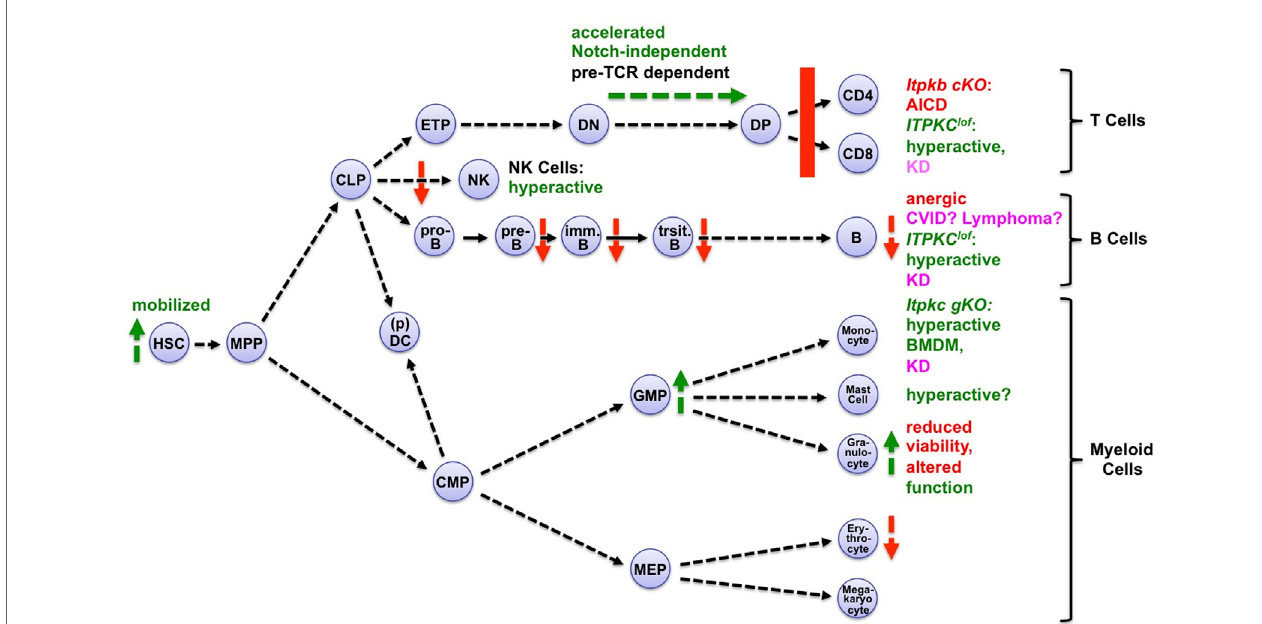
FigURe 3 | Itpks control multiple aspects of hematopoiesis. Shown are aspects of hematopoiesis affected positively (green symbols and fonts) or negatively (red symbols and fonts) by inactivation of Itpkb or Itpkc. Pink, human diseases associated with loss-of-function (lof) alleles of ITPKC (Kawasaki disease, KD) or ITPKB (common variable immunodeficiency, CVID). Abbreviations: cKO , conditional, gKO , germline knockout mice; AICD, activation-induced cell death; BMDM, bone marrow-derived macrophages. Hematopoietic cell stages and pathways are explained in the legend to Figure 2 . For more details and references, see text. Mast cells express Itpkb and produce IP 4 after stimulation (53). Small-molecule Itpk inhibition might augment their activation (54, 55), but the target selectivity of the low-affinity Itpk inhibitors used is unknown and genetic studies are needed. Adapted with permission from Ref.